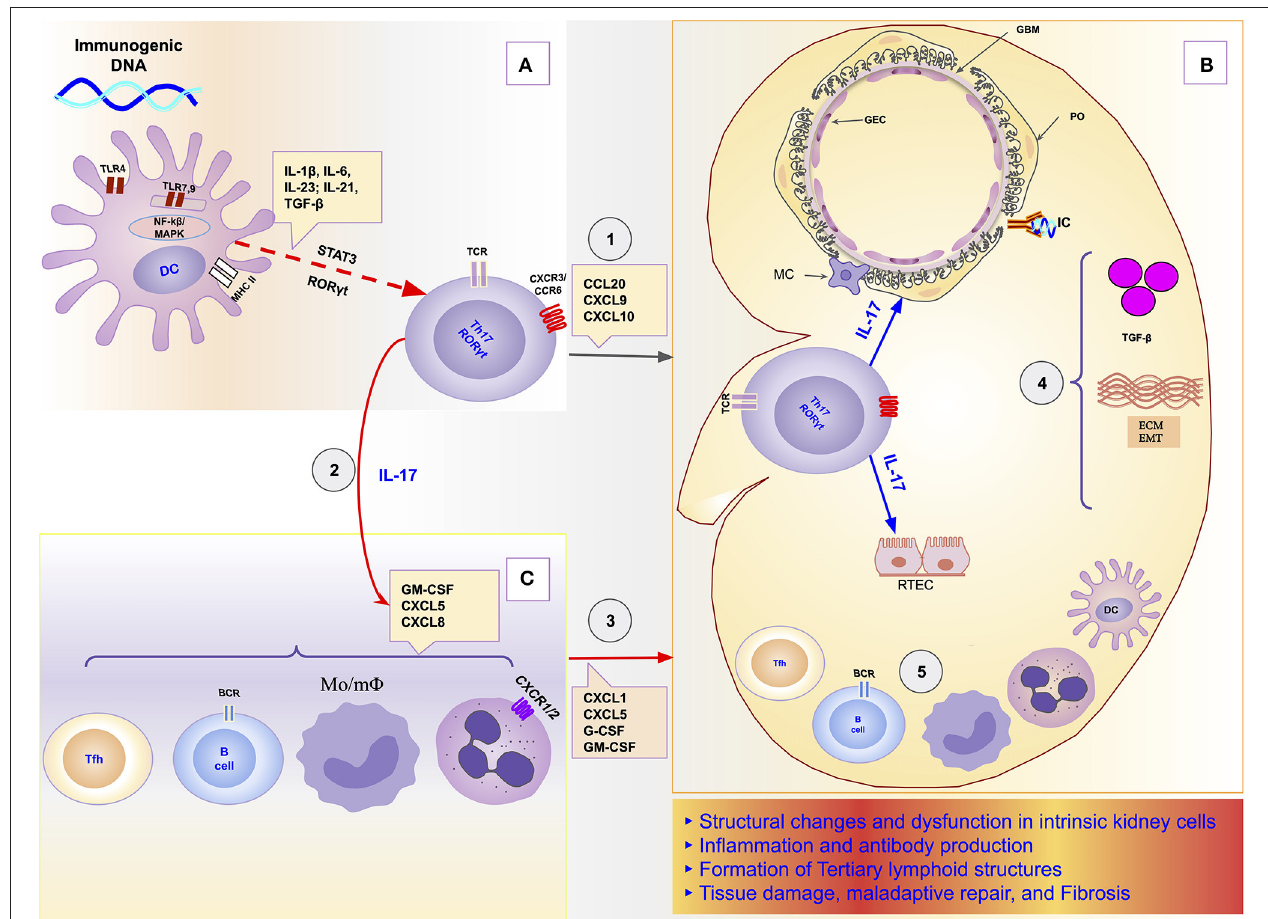
FIGURE 1 | Schematic representation of the role of the Th17/IL-17 axis in the chain of events to kidney damage and ESRD in Lupus Nephritis. (A) Dendritic cells sense extracellular DNA through TLR4 present in their plasma membrane (69, 71, 72) or sense phagocyted DNA-containing immune complexes by TLR7 and TLR9 in endosome ( 69, 74, 75). The binding of DAMPs to TLRs in APCs induces their maturation (76, 77). Part of dendritic cells migrates to draining lymph nodes to present the processed antigen to T cells and induce their activation and differentiation. The differentiation of Th17 cells is promoted by proinflammatories cytokines (IL-1 β , IL-6, IL-21, IL-23) that dendritic cells secrete using the NF- κ B and MAPK signaling pathways ( 77, 83). Dendritic cells that remained in the tissue secrete various chemokines like CXCL9, CXCL10, and CCL20 that drive the recruitment of Th17 cells to the kidney through binding to receptors (CXCR3 and CCR6) ( 96, 125, 126). (B) In the Kidney, Th17 releases its cytokines (IL-17A, IL-17F, IL-17C, IL-21, and IL-22) that act directly on intrinsic kidney cells (mesangial cells, podocytes; glomerular endothelial cells, renal tubular epithelial cells). IL-17 family cytokines are responsible for changes in the cytoskeleton of the podocytes, activation of inflammasome and caspases, and induction of oxidative stress and podocytes apoptosis. In addition, in tubular epithelial cells, IL-17 promotes the activation of the profibrotic pathways with the increase of the expression of TGF- β (36, 87), promotion of EMT (158) with consequent increase of extracellular matrix proteins and fibrosis (87). (C) Besides local effects, IL-17 amplifies the systemic inflammatory response by stimulating the synthesis of inflammatory cytokines, growth factors, and chemokines, resulting in granulopoiesis/myelopoiesis and recruitment of more immune cells to the kidney (31, 32, 194). In addition, it promotes autoantibody production by its effects on Tfh and GC (195, 196), and plasma cells (197). DC, dendritic cells; ECM, extracellular matrix; EMT, epithelial-mesenchymal transition; GBM, glomerular basement membrane; GEC, glomerular endothelial cells; IC, immune complex; IL-1, Interleukin-1; IL-17, Interleukin-17; IL-21, Interleukin-21; IL-23, Interleukin-23; IL-6, Interleukin-6; MAPK, Mitogen-activated protein kinase; MC, mesangial cell; Mo / m Φ , Monocytes/macrophages; NF- κ B, Nuclear factor- κ B; PO, podocyte; RTEC, renal tubular epithelial cells; Tfh, follicular helper T cells; TGF- β , transforming growth factor-beta; Th17, T helper lymphocytes, subtype 17; TLR2, Toll-like receptor 2; TLR4, Toll-like receptor